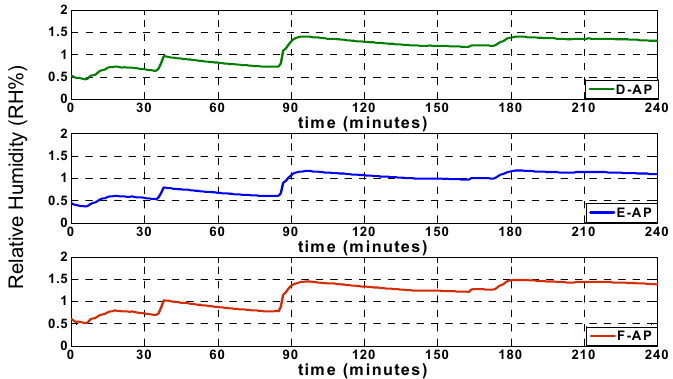
Figure 12. Performance of different approximation platforms